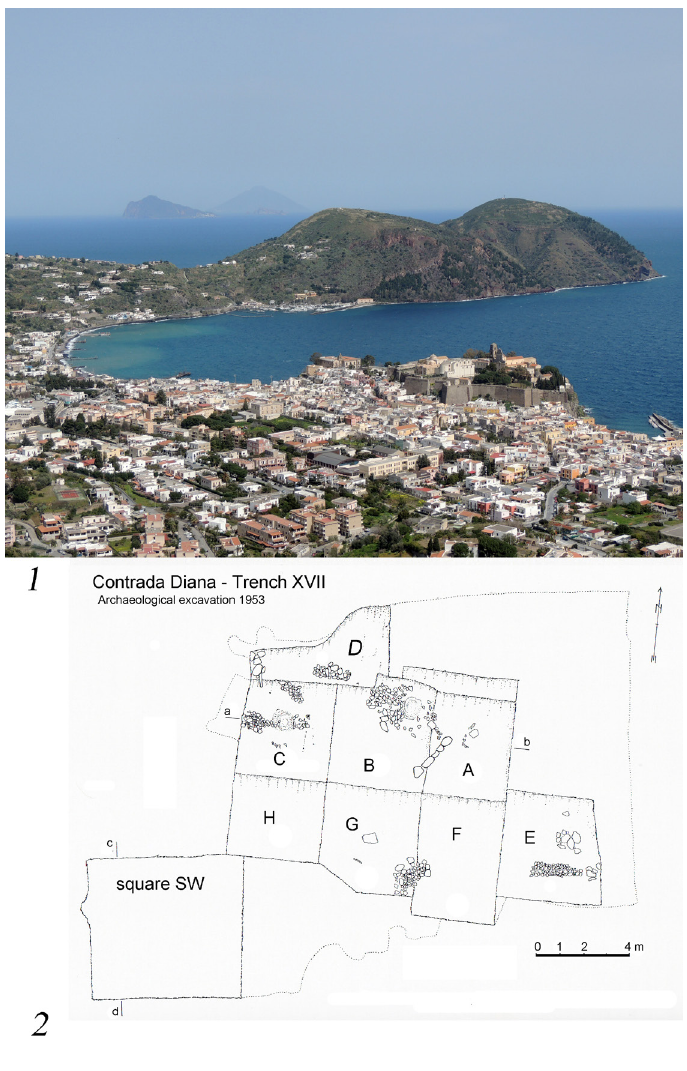
Figure 2. 1. Lipari Island: Contrada Diana area and Acropoli. 2. Lipari, Contrada Diana settlement: Map trench XVII (Bernabò Brea & Cavalier, 1960, p. 8 and figure